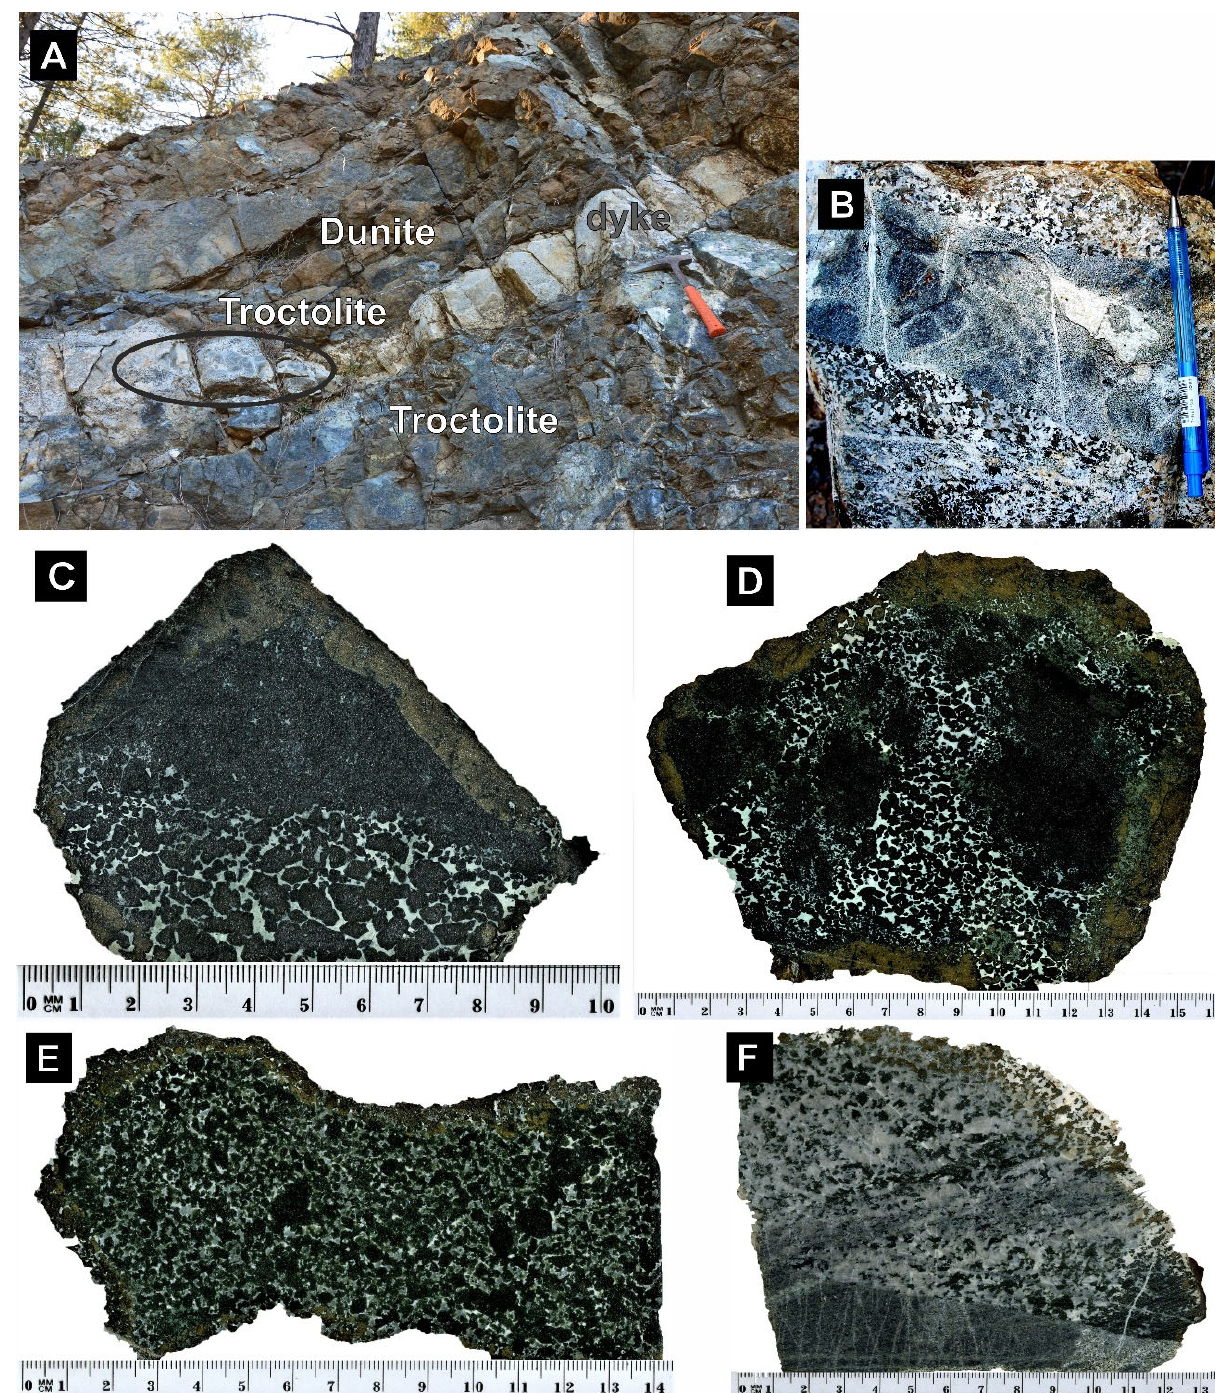
Figure 10. An outcrop in Donja Paklenica Valley peridotite with a dyke at the dunite ‐ troctolite boundary. ( A ) Troctolite is crosscut by dolerite dyke (a detail view on the circle domain in B ). ( B ) Dolerite dyke (P18G2) crosscutting troctolite (from A ). ( C–E ) Secondary Pl enrichment of Ol ‐ Spl dunite (black parts) and the formation of Ol ‐ Pl ‐ (±Cpx) troctolite (the area above the dyke in A ). ( F ) Troctolite crosscut by fine ‐ grained Pl ‐ rich vein (at the bottom).